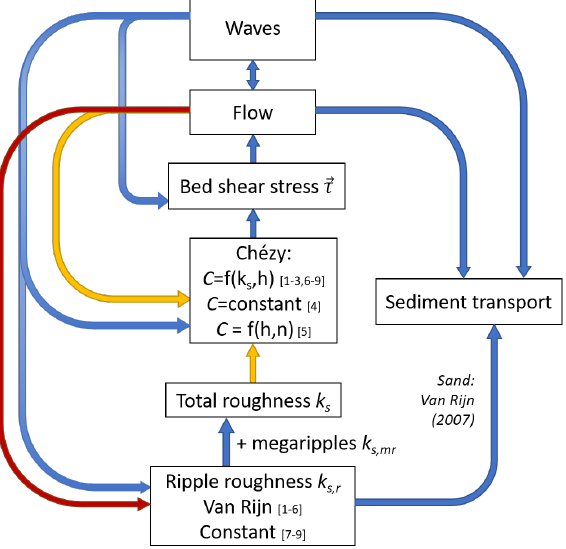
Figure 1. Schematic overview of interaction and feedbacks related to ripples and megaripples in Delft3D. The numbers refer to the scenarios explained in Section 2.3. Yellow arrow: this effect is removed by choosing a constant Chézy value C (scenarios 4–5, note that sediment transport in this case still depends on k s , r ). Red arrow: this effect is removed by choosing a fixed ripple roughness (scenarios